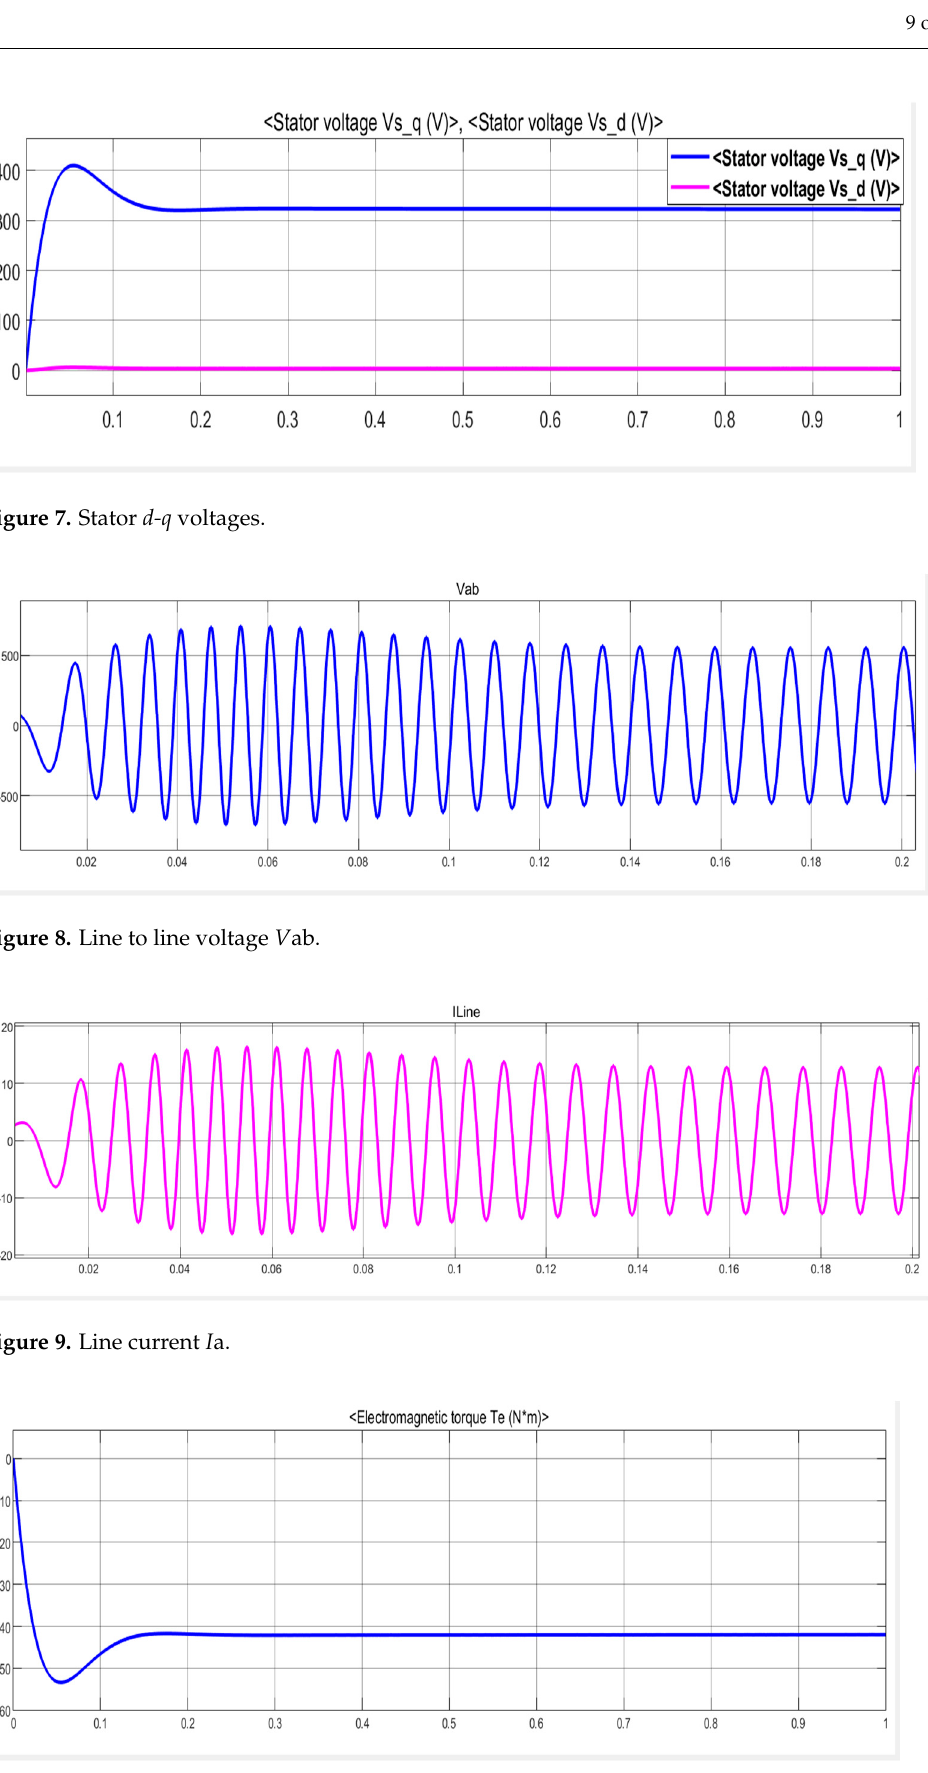
Figure 10. Electromagnetic torque.